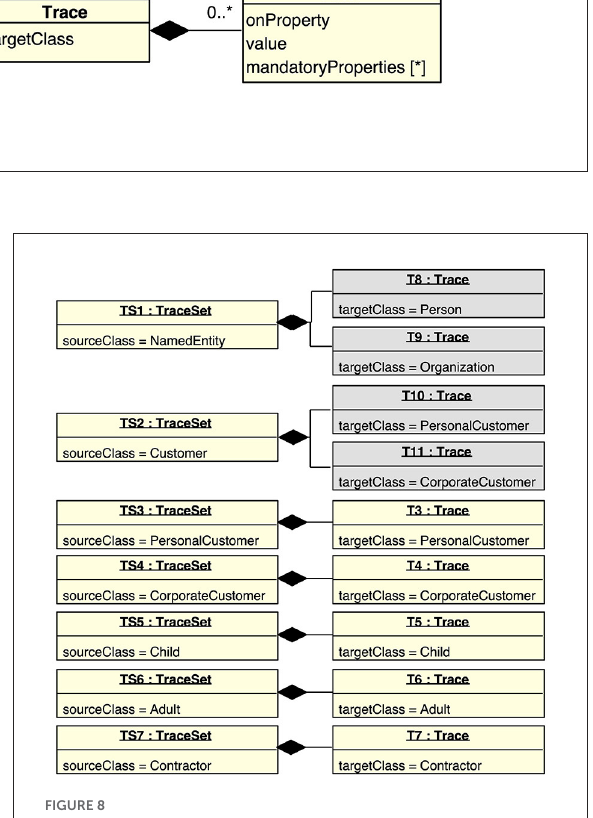
FIGURE8 Trace table after the flattening of NamedEntity and Customer